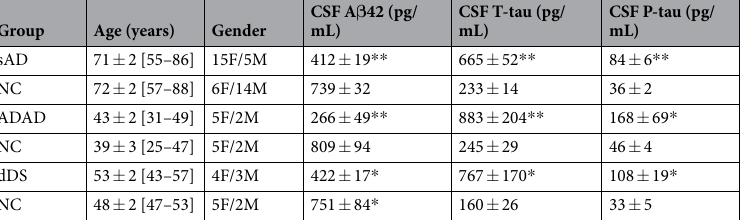
Table 1. Clinical, demographic data and classic CSF biomarker levels. The PSEN1 mutations included in this study from ADAD cases (autosomal dominant AD subjects) corresponded to 3 carriers of L286P, and one S169P, L173F, L235R and L282R. The data represent the means ± SEM, and for age the range of values is also indicated. All the pathological groups were compared with age-matched NC obtained from the same Hospital. Significantly different ** p < 0.005; * p < 0.05 from the NC